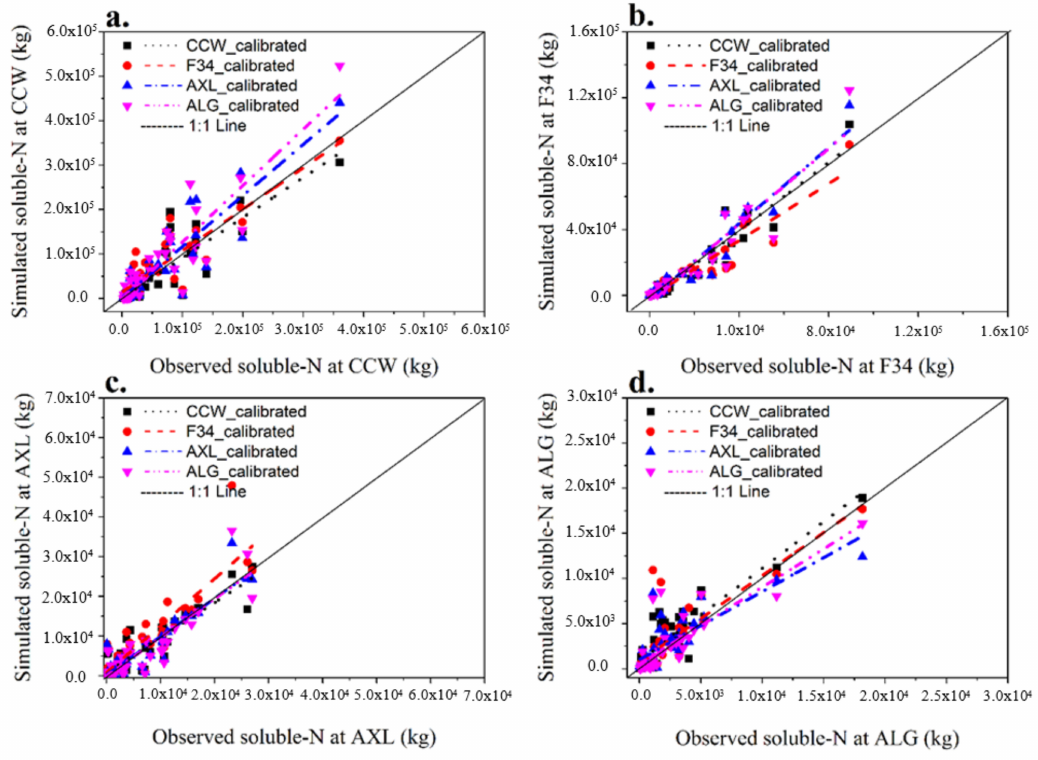
Figure 4. One-to-one plots of SWAT simulated vs. observed monthly soluble N loads at the ( a ) CCW outlet, ( b ) F34 outlet, ( c ) AXL outlet, and ( d ) ALG outlet for the calibration period from January 2006 to December